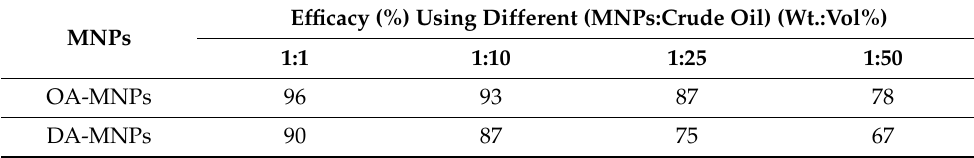
Table 1. Efficacy (%) of OA-MNPs and DA-MNPs in the collection of an oil spill.